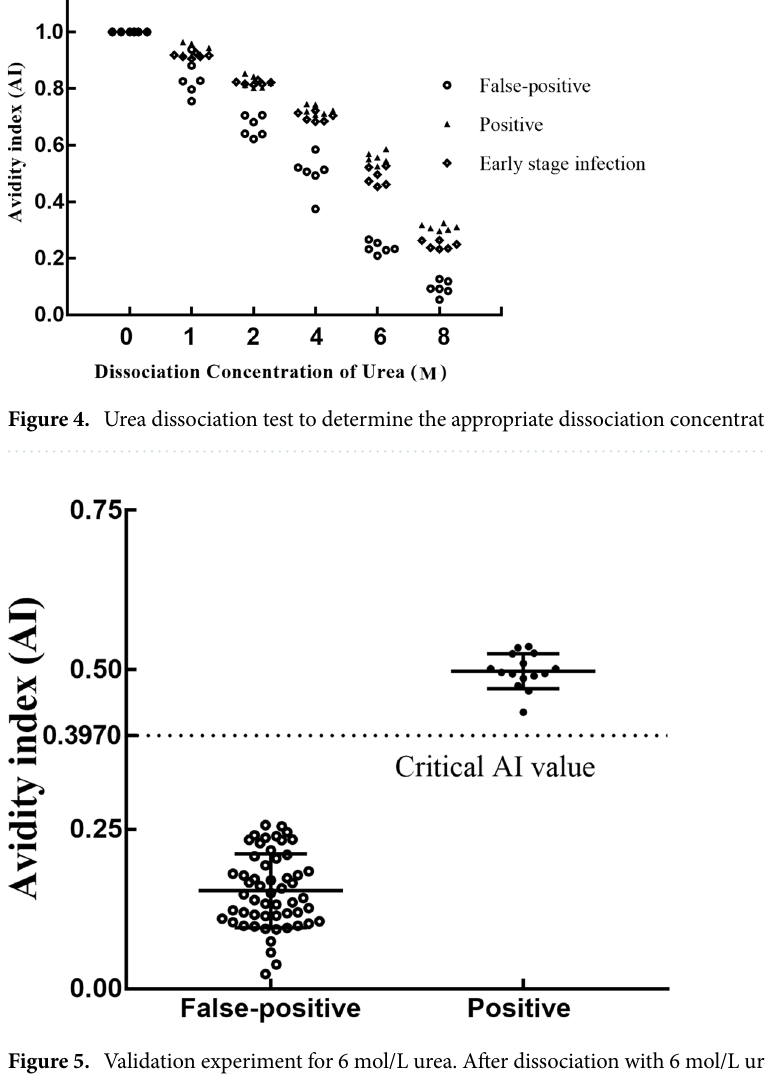
Figure 5. Validation experiment for 6 mol/L urea. After dissociation with 6 mol/L urea, the AI of false-positive serum samples was measured, and the sensitivity and specificity values were